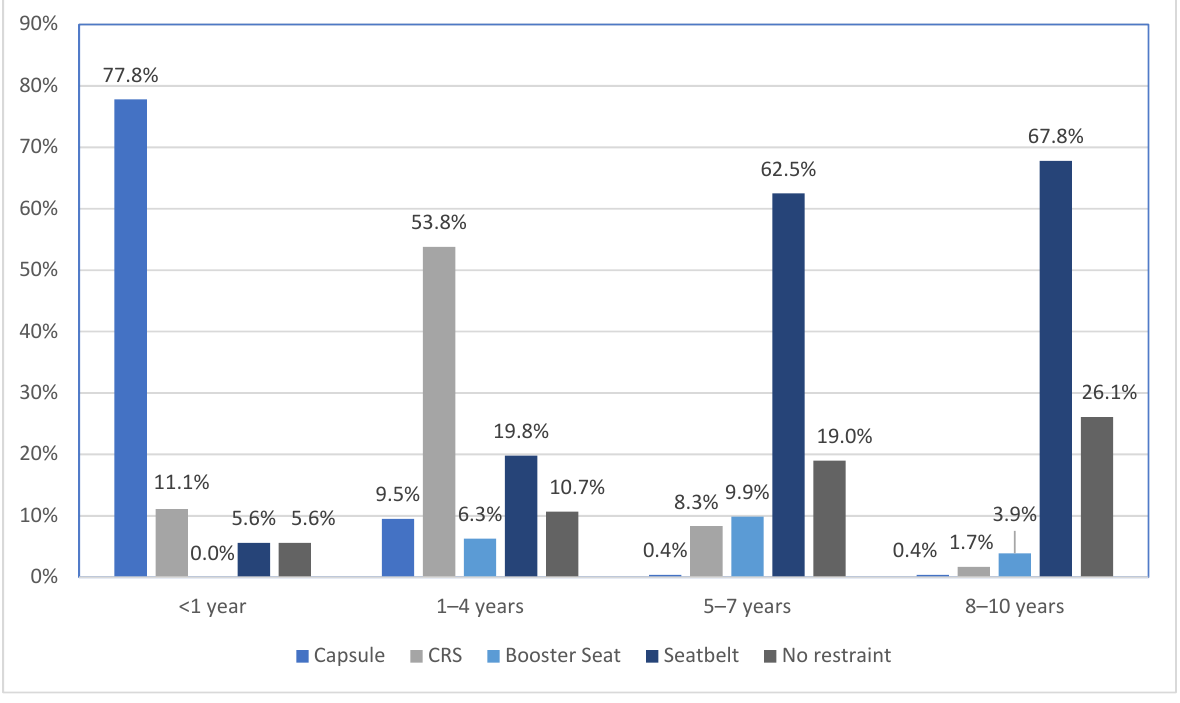
Figure 3. Type of restraint by age group for the eldest child.